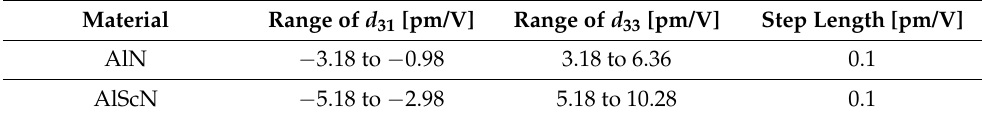
Table 1. The simulation parameter range settings.